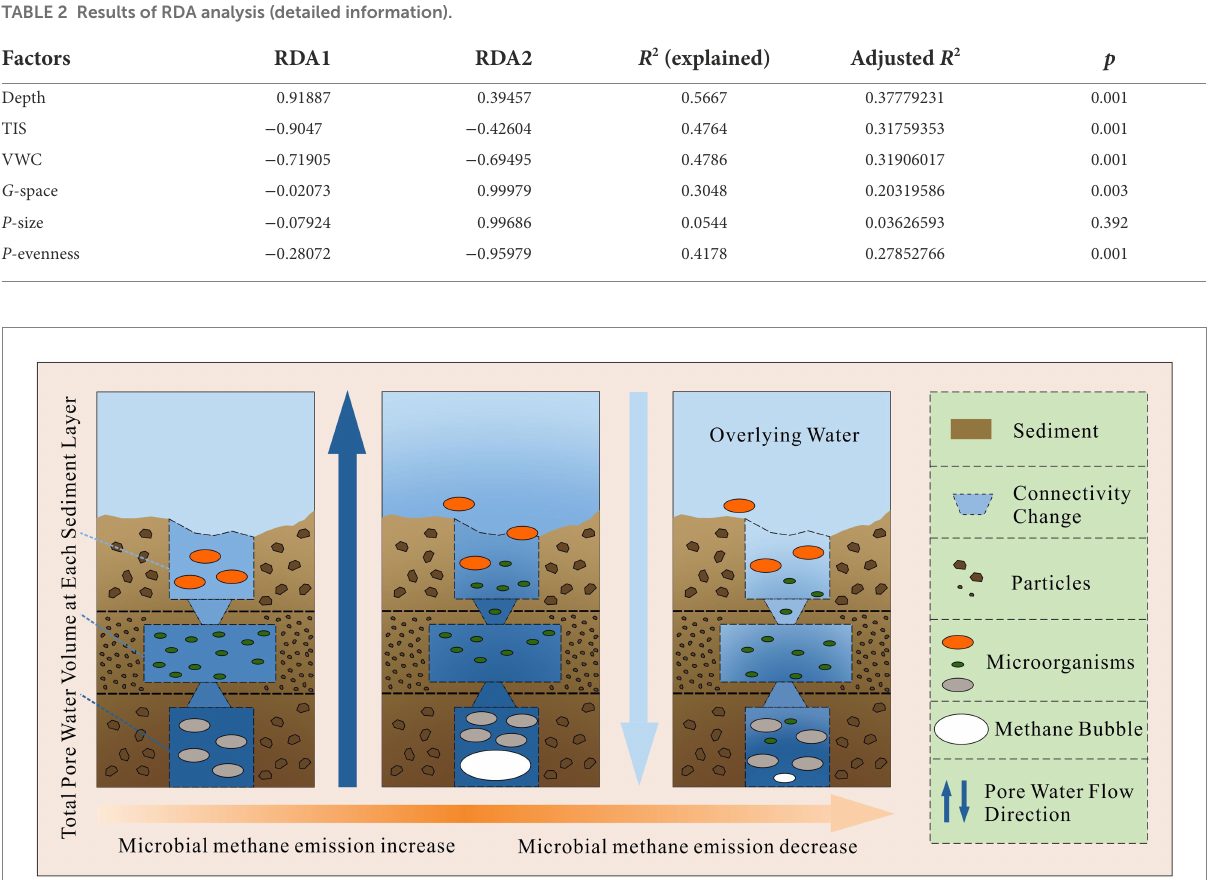
FIGURE 8 The theoretical processes of how methane bubble variations affect sediment microbial communities along depth